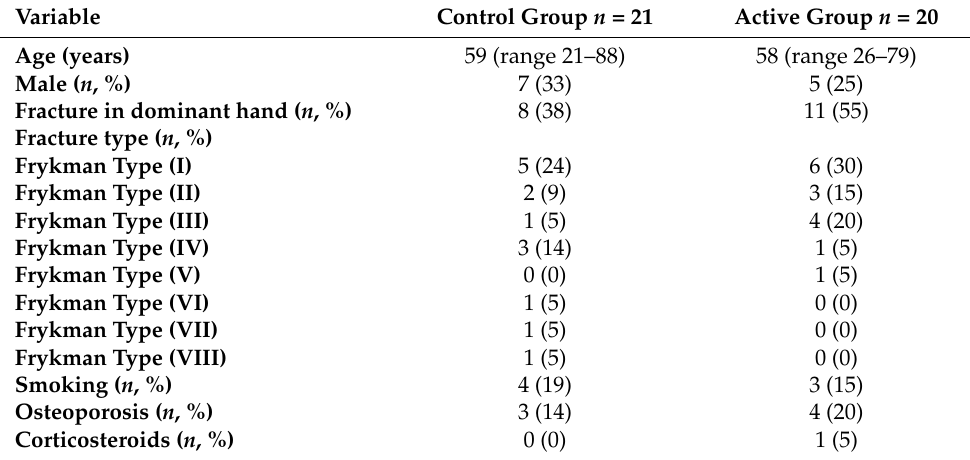
Table 1. Patients’ demographics.